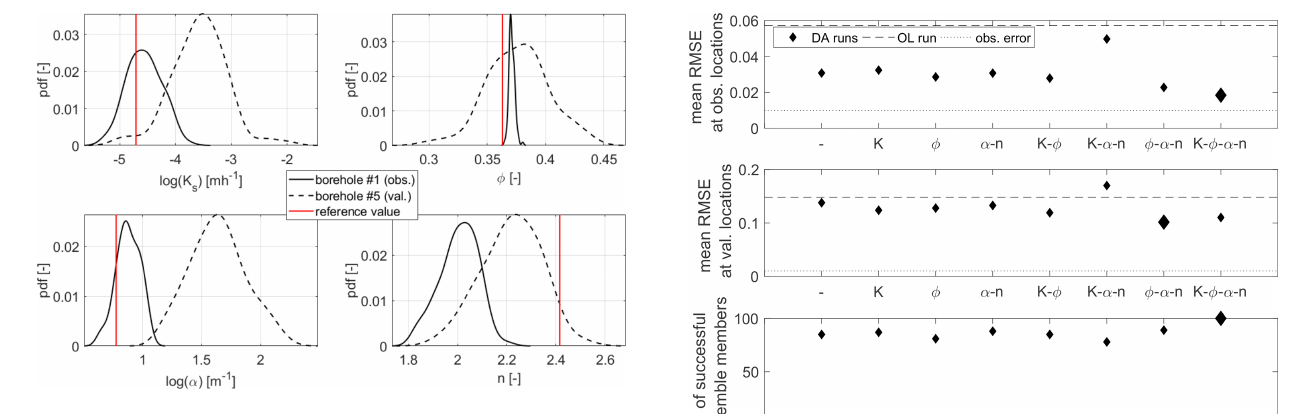
Figure 9. Estimated probability density functions (pdf’s) of the four parameters for the heterogeneous scenario at one observation and one validation location and z 2 = 0 . 75m below the surface after the last update. The reference values are plotted in red. Figure 10. Spatially and temporally averaged RMSE values at the observation and validation locations for the heterogeneous scenario and the different parameter update combinations. The first entry (–) denotes the data assimilation run where only soil moisture is up- dated. The lower plot gives the number of converging ensemble members. The best values are highlighted by larger